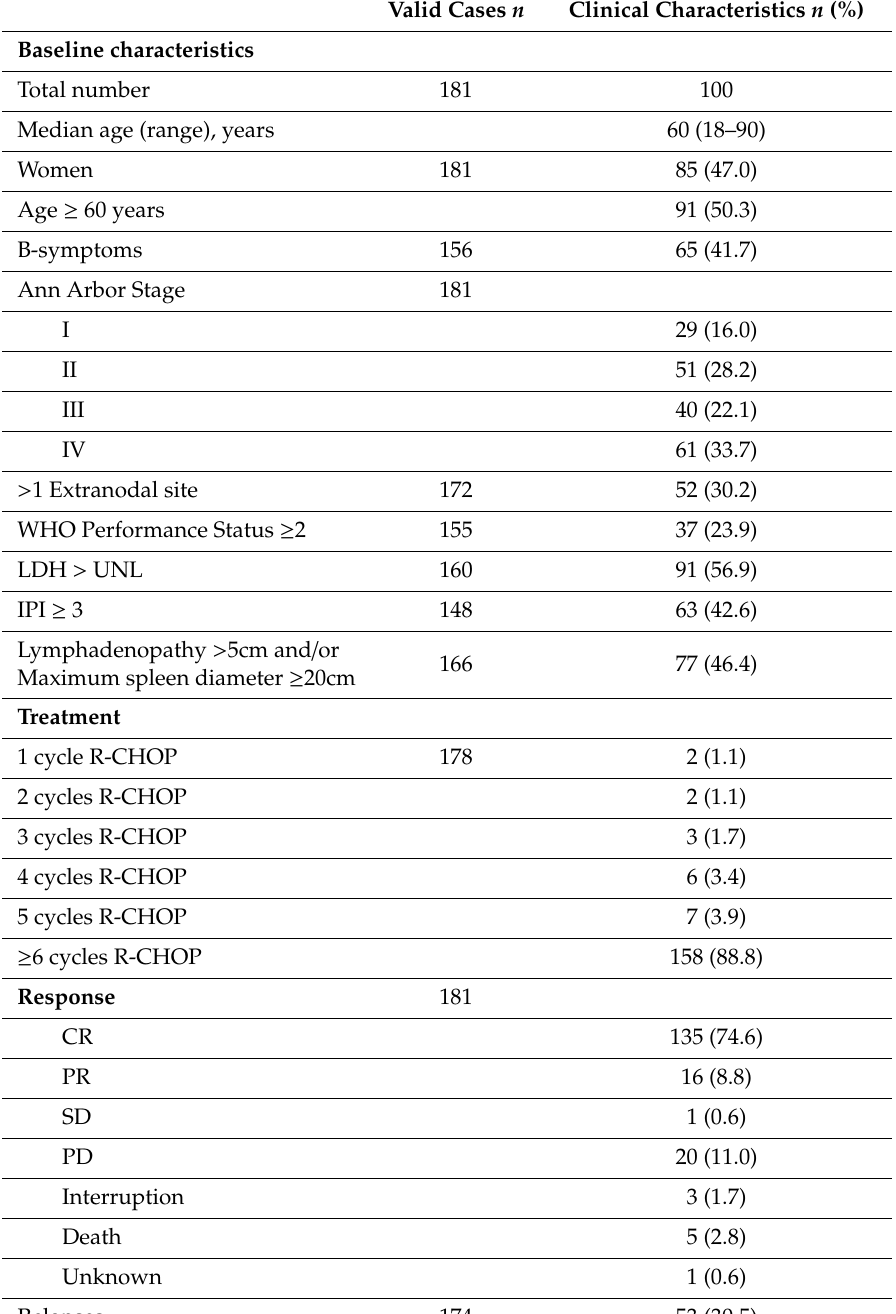
Table 1. Clinical